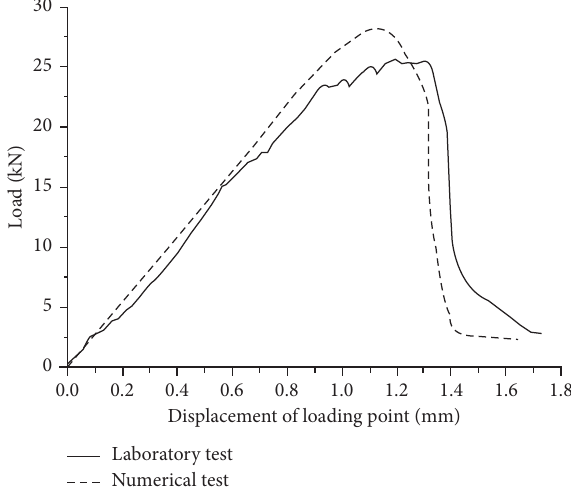
Figure 5: Load-displacement curve of Brazil test (parameter of group